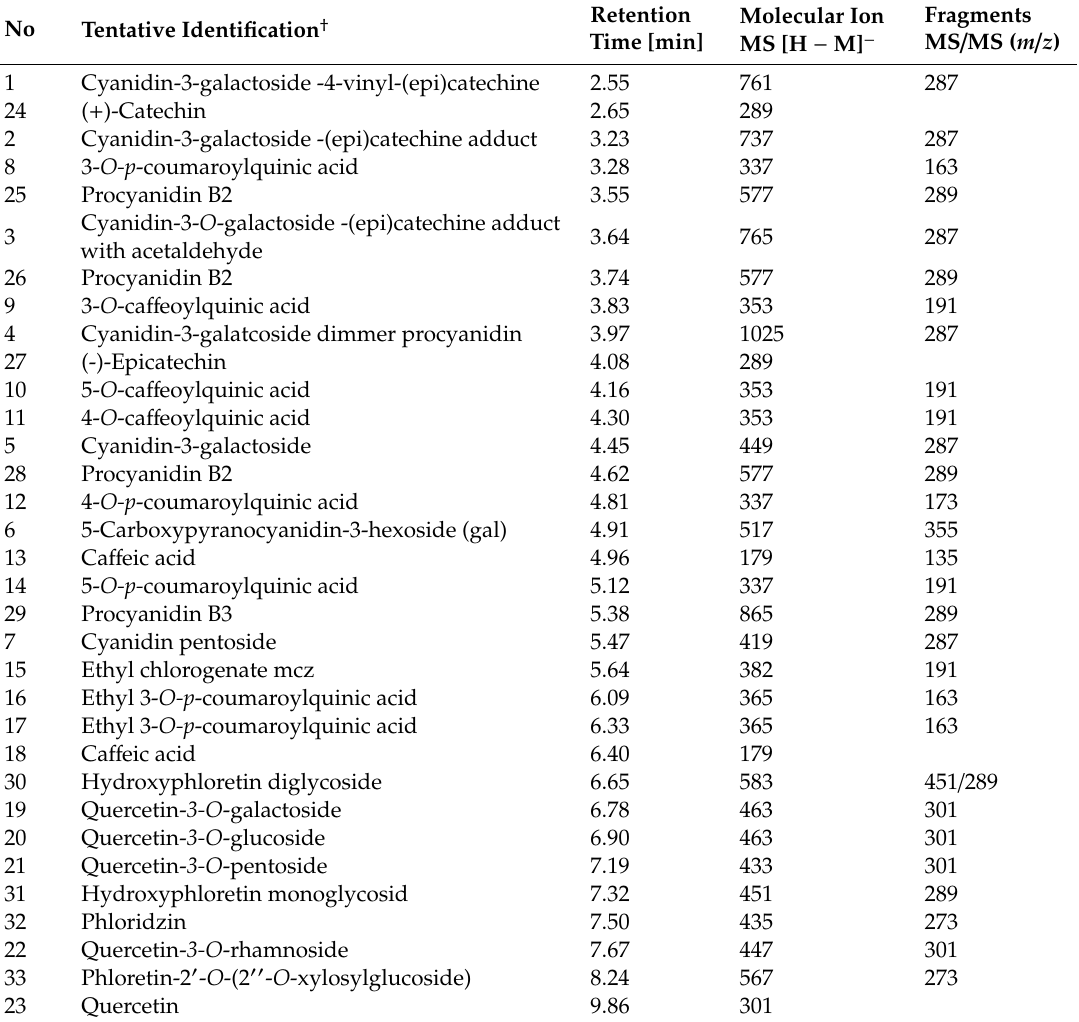
Table 3. Identification of polyphenols in red apple